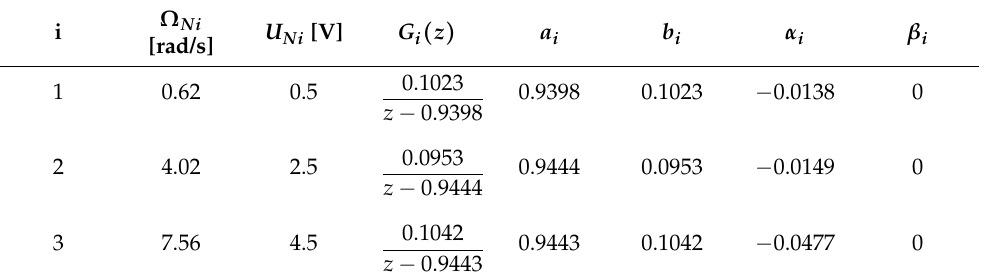
Table 1. Nominal values and linear models of the